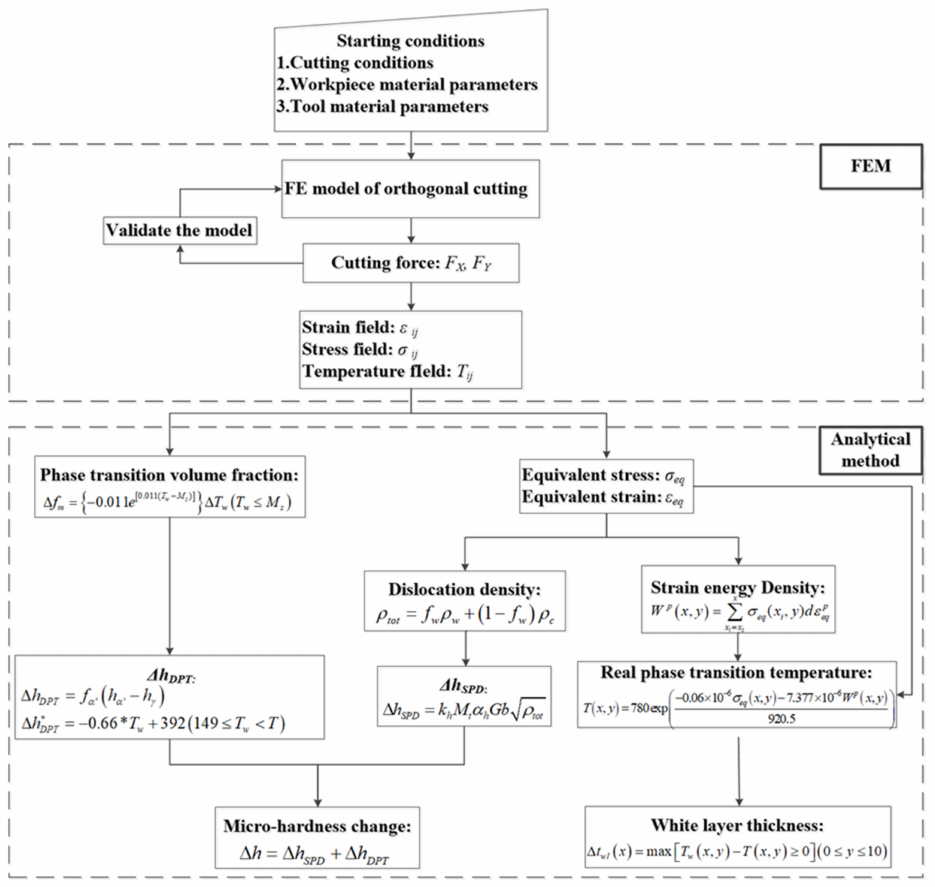
Figure 5. The flow chart of the methodology for the multiphysics prediction